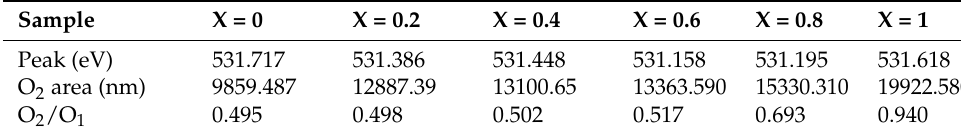
Table 4. Gaussian-fitted peaks for O 1s XPS spectra for Mn X Co 3-X O 4 (0 ≤ X ≤ 1) samples.